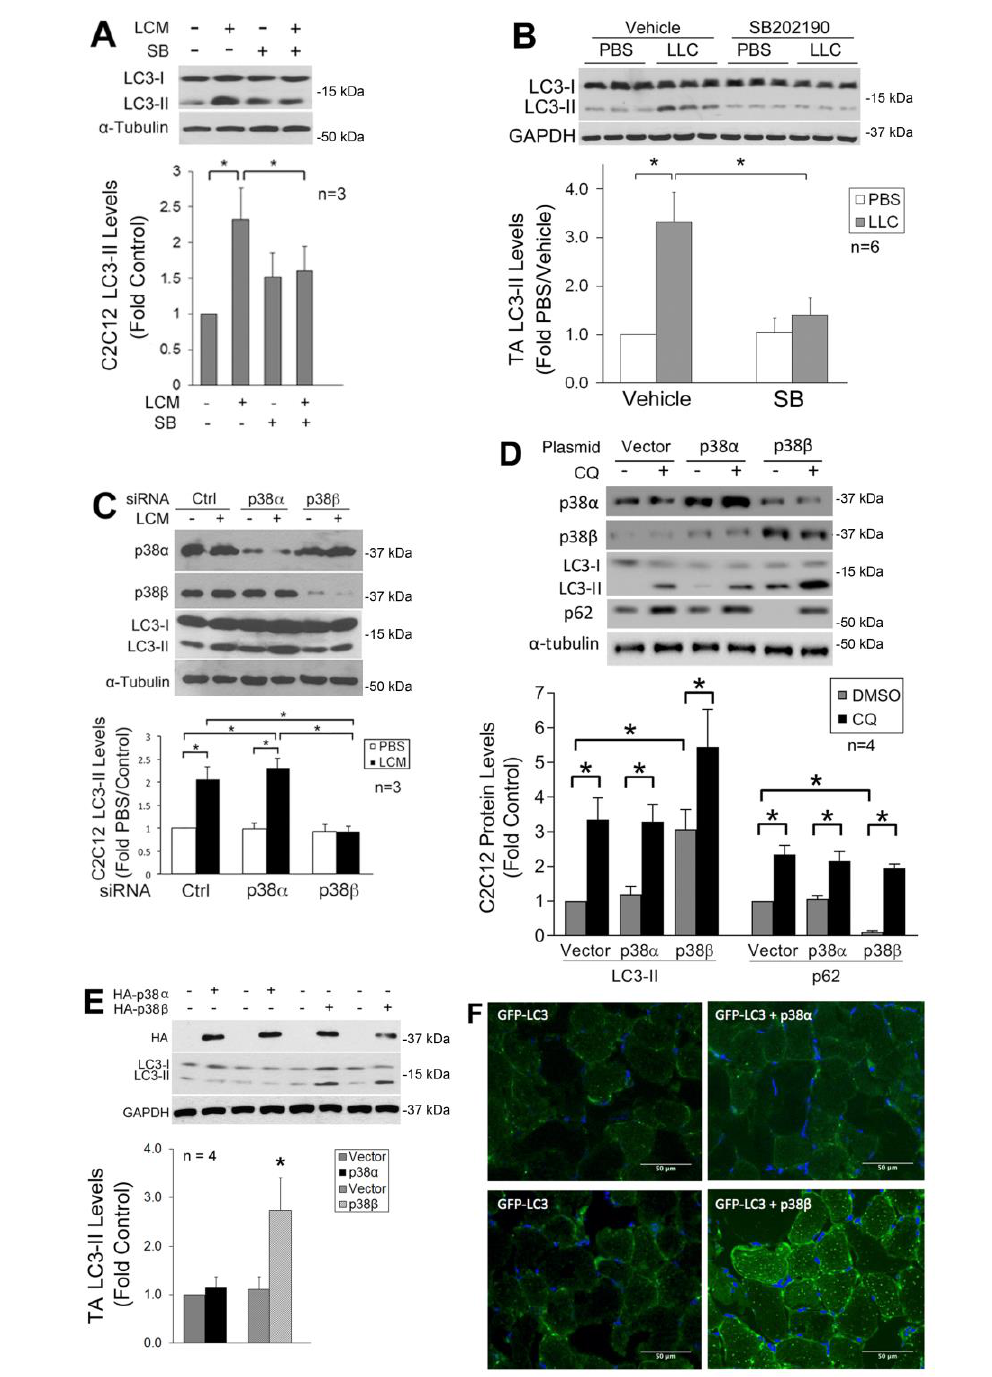
FIGURE 1: p38 MAPK activation is necessary and sufficient for autophagy activation by tumor in skeletal muscle cells. (A) Inhibition of p38 MAPK attenuates LLC- conditioned medium (LCM)-induced autophagy activation in C2C12 myotubes. C2C12 myotubes were pretreated with SB202190 (SB, 10 M) or vehicle (0.1% DMSO) for 30 min prior to treatment with LCM or control medium (NL20) for 8 h. Autophagy activation was evaluated by Western blotting analysis of LC3 in cell lysate. (B) Inhibi- tion of p38 MAPK attenuates autophagy activation in skeletal muscle of LLC tumor-bearing mice. In 7 days of LLC implant to mice, SB202190 was i.p. injected (5 mg/kg) daily with DMSO (50%) as vehicle control for 14 days. Lysate of TA collected on 21 days of LLC implant was analyzed by Western blotting for LC3 (samples from 3 mice per group were loaded on each gel). (C) LCM-induced autophagy activation in myotubes is dependent on p38 MAPK. C2C12 myoblasts were transfected with control, p38 MAPK or p38 MAPK-specific siRNA. After differentiation, myotubes were treated with LCM or control medium for 8 h. Autophagy activation was evaluated by Western blotting analysis of LC3. (D) Expression of constitutively active p38 MAPK stimulates autophagy flux in C2C12 myotubes. Plasmids encoding a constitutively active mutant of p38 MAPK or p38 MAPK with the HA tag were transfected into C2C12 myoblasts, with empty vector as control. After differentiation, myotubes were treated with chloroquine (CQ, 20 M) for 8 h. LC3, p62 and expression of the p38 MAPK mutants were monitored by Western blotting. (E) Constitutively active p38 MAPK activates autophagy in mouse muscle. Plasmids encoding the constitutively active mutant of p38 MAPK or p38 MAPK fused with the HA tag were transfected into the TA of mice. Empty vector was transfected into the contralateral TA. On day 14 expression of the p38 MAPK mutants and autophagy activation was analyzed by Western blotting (data from two mice per group are shown). Data were analyzed by one way ANOVA. * denotes a difference between bracketed groups or from con- trols (p < 0.05). (F) Constitutively active p38 MAPK stimulates autophagosome formation in mouse muscle. A plasmid encoding GFP-LC3 was transfected into mouse TA muscle, and co-transfected with the plasmid encoding the constitutively active mutant of p38 MAPK or p38 MAPK in the contralateral TA. In 7 days, TA muscle was collected. Frozen sections were prepared and stained with DAPI. Autophagosome formation was evaluated by confocal microscopy. Bars represent 50 OPEN ACCESS | www.cell-stress.com